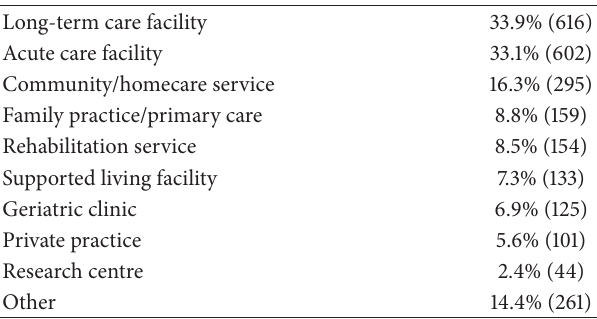
Table 1: Practice